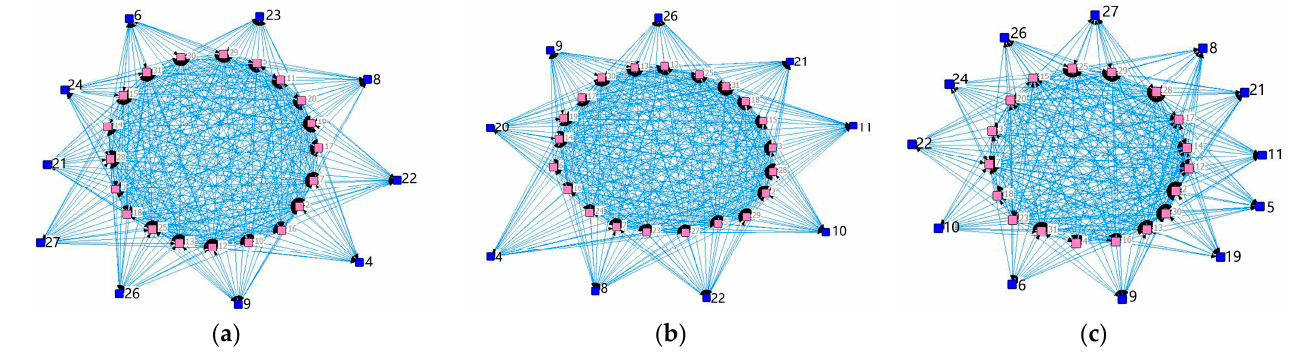
Figure 9. K-cores of the ECETNs in the three provinces of Hei-Ji-Liao. ( a ) K-core for ECETN in Liaoning; ( b ) K-core for ECETN in Jilin; ( c ) K-core for ECETN in Heilongjiang.